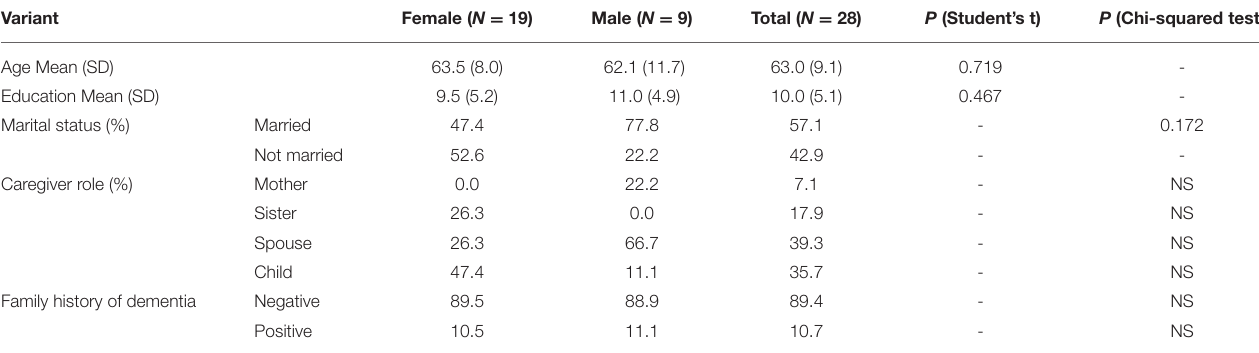
TABLE 1 | Demographic, caregiver and family history data.